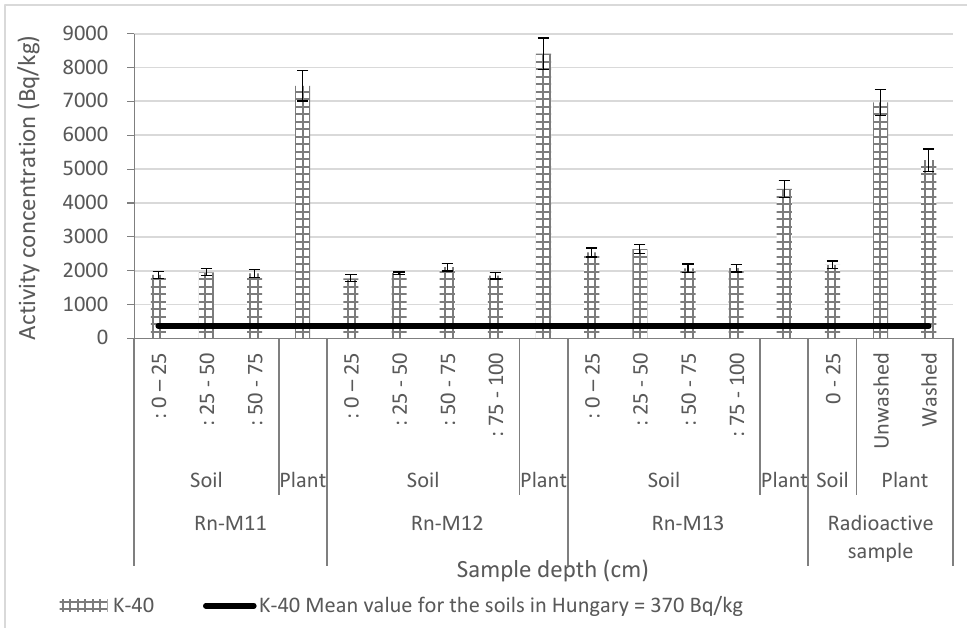
Figure 2. Activity concentrations for K-40 measured in soil and plant samples. The activity concentrations for U-238, Th-232, and U-235 radionuclides in the soil samples in each depth and the concentrations for the plant samples collected at the same location are shown in Figure 3. The activity concentrations for U-238 and Th-232 in soil were compared to the mean values for Hungary as reported by UNSCEAR [66]. The re- sults for the radioactive sample are presented separately in Figure 4 to indicate the behav- ioral patterns for the U-238 and its progenies since U-238 had elevated concentrations in this location.